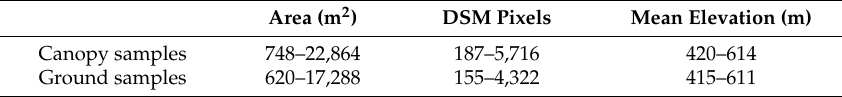
Figure 5. Scheme of sample selection. Subgraphs ( a–d ) illustrate the setting of canopy samples and ground samples referencing the false color composite ZY3-02 multispectral image and the ZY3-02 DSM displayed with hill shade effect. Subgraph ( e ) shows the locations of all 51 canopy height samples (which were also the locations of the canopy samples) and marks the training samples and validation samples. Table 1. Area, DSM pixel counts, and mean DSM elevation of the sampling areas.